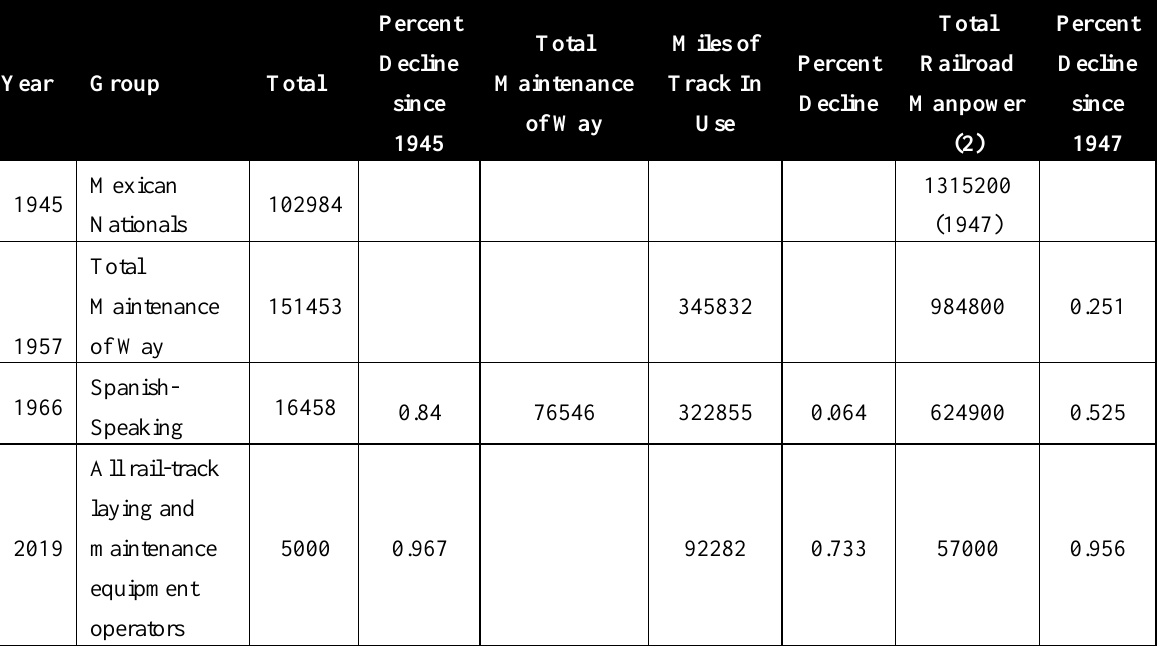
Table 2. Mexican/Spanish-Speaking Employment on